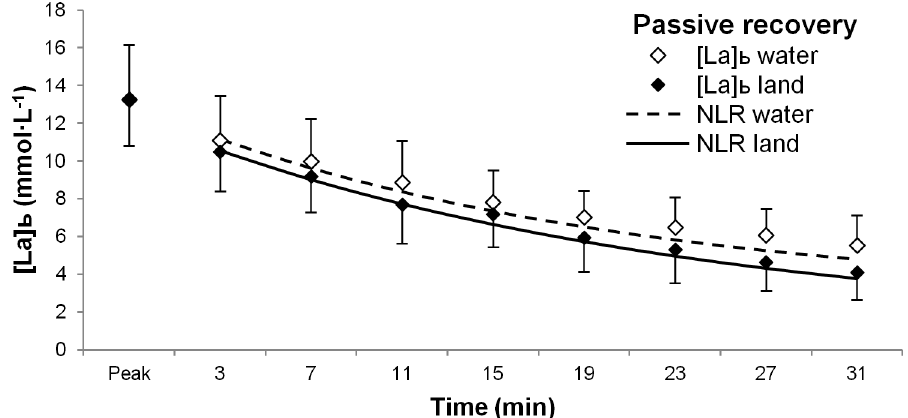
Fig 2. Blood lactate removal during passive recovery. Blood lactate concentration decays duringwater- based(white diamonds) and land-based (black diamonds) passive recovery conditionsfollowinga 30-second all-out bout of cycling. Non-linearregressioncurves are also shown for water-based (dashedline) and land- based(solid line) recovery. Abbreviations: [La] b , blood lactate concentration; NLR, non-linearregression.